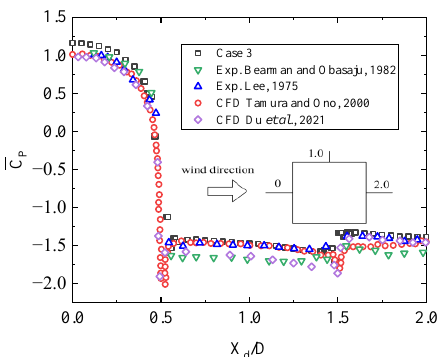
Figure 5. Comparison of average wind pressure coefficients [5,6,11,12].